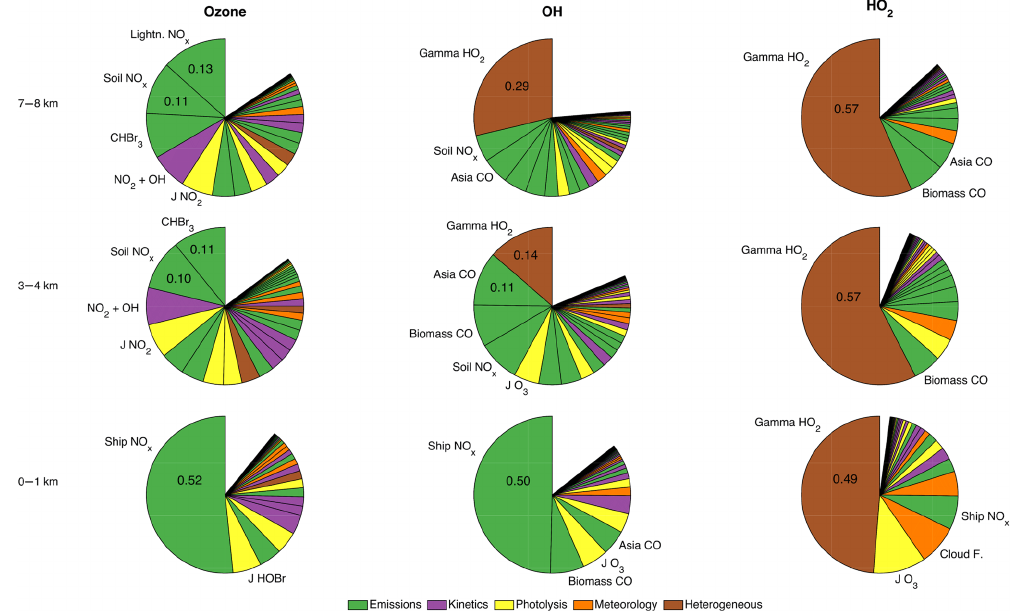
Figure 9. First-order sensitivity indices for median flight track ozone, OH, and HO 2 for INTEX-B flights originating from and terminating in Anchorage. Legend categories are defined in Table 2. Sensitivity indices are labeled in pie slices for factors for which S i ≥ 0 . 10.